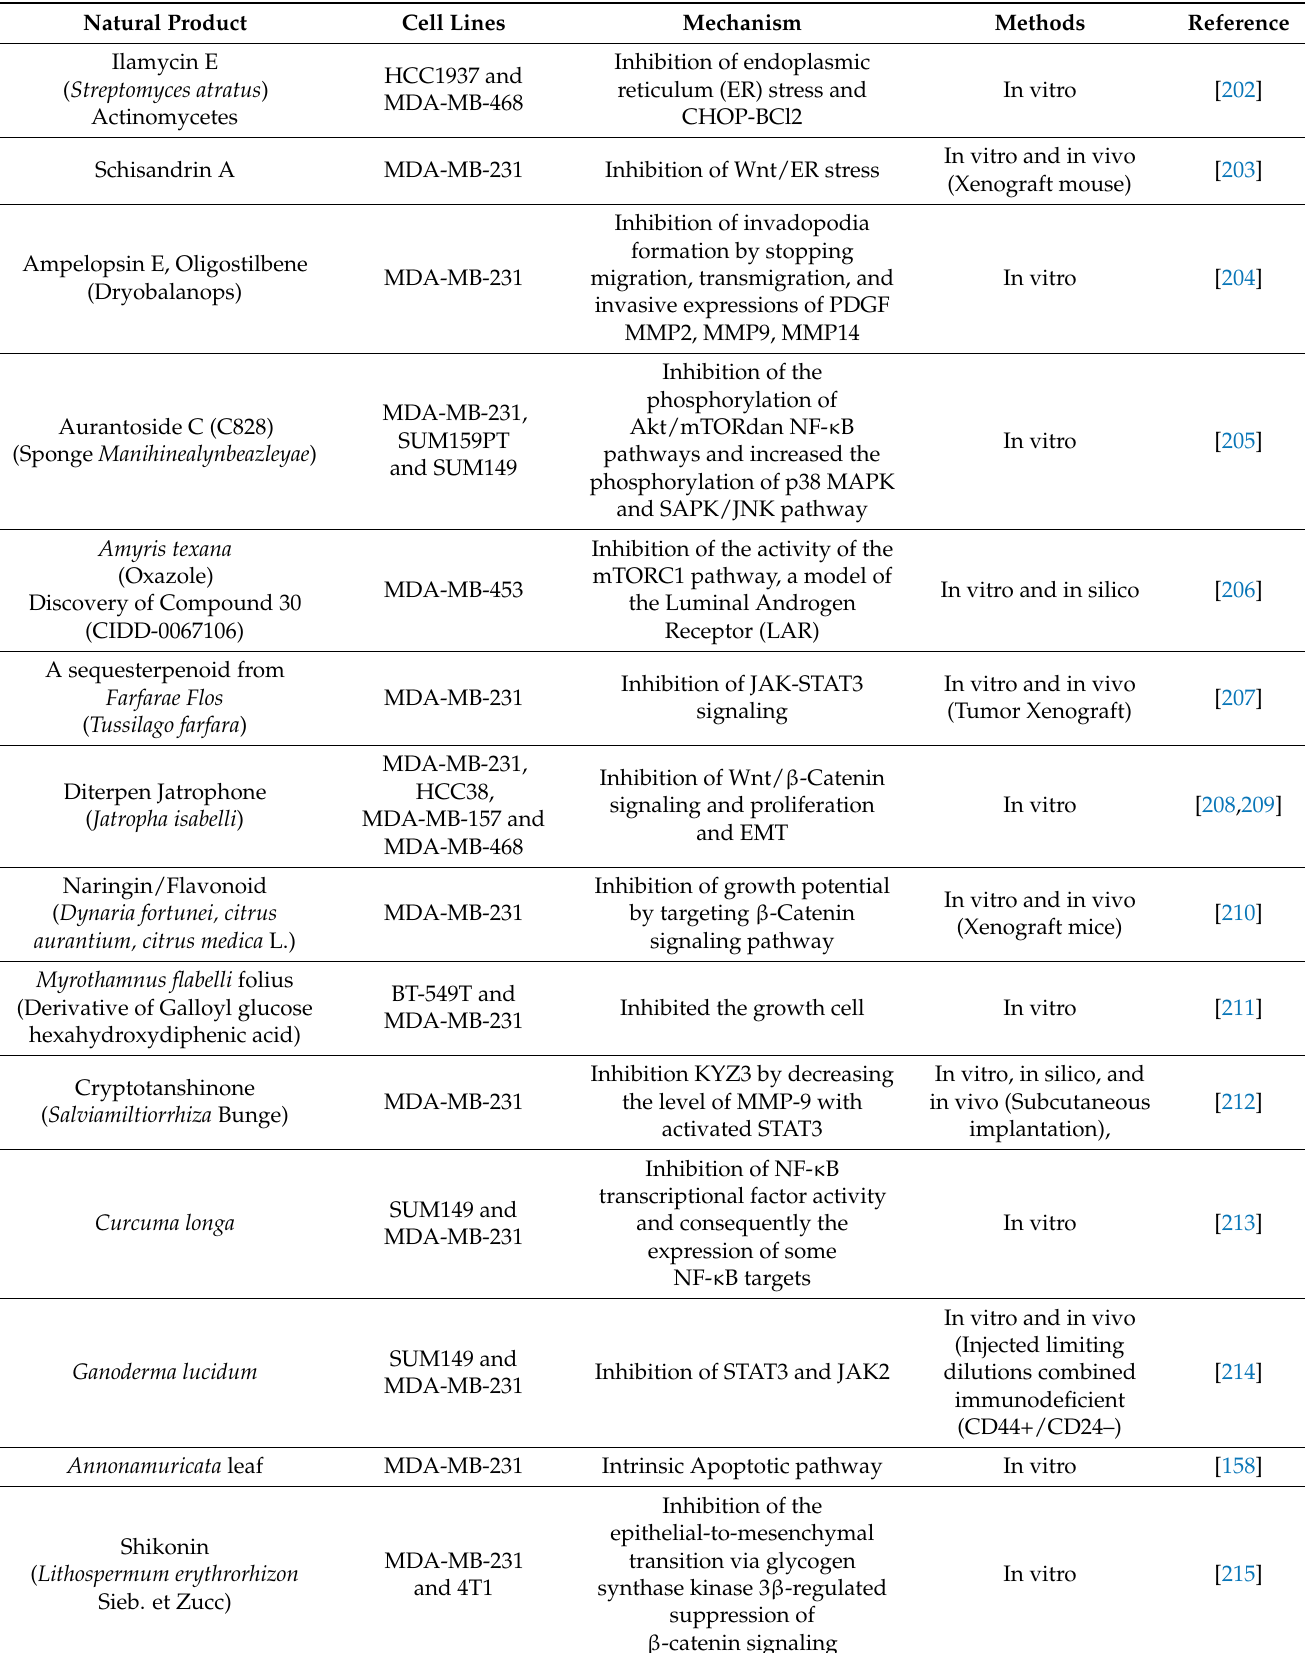
Table 2. Natural compound’s activity in cell line and its